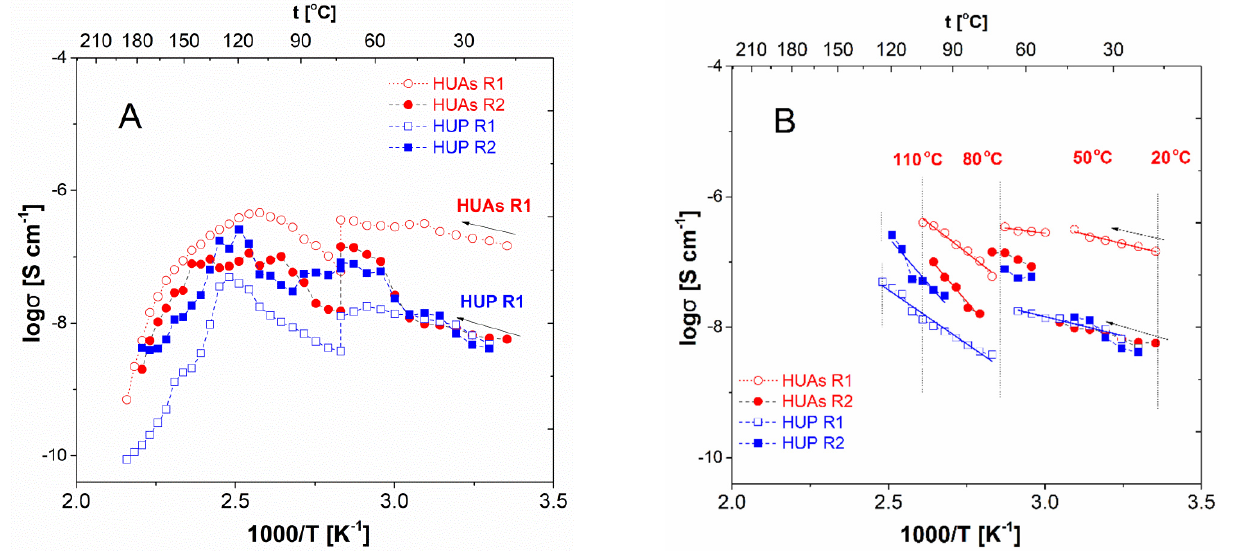
Figure 6. Arrhenius plot of R1 (empty symbols) and R2 (full symbols) conductivities for HUP (UO 2 )(HPO 4 )(H 2 O) 4 ( (cid:4) ) and HUAs (UO 2 )(HAsO 4 )(H 2 O) 4 ( • ) materials; ( A )—Arrhenius plots in a whole measured temperature range ( B )—low and medium temperature parts of HUP and HUAs Arrhenius plots split into three independent ranges of linear dependencies.